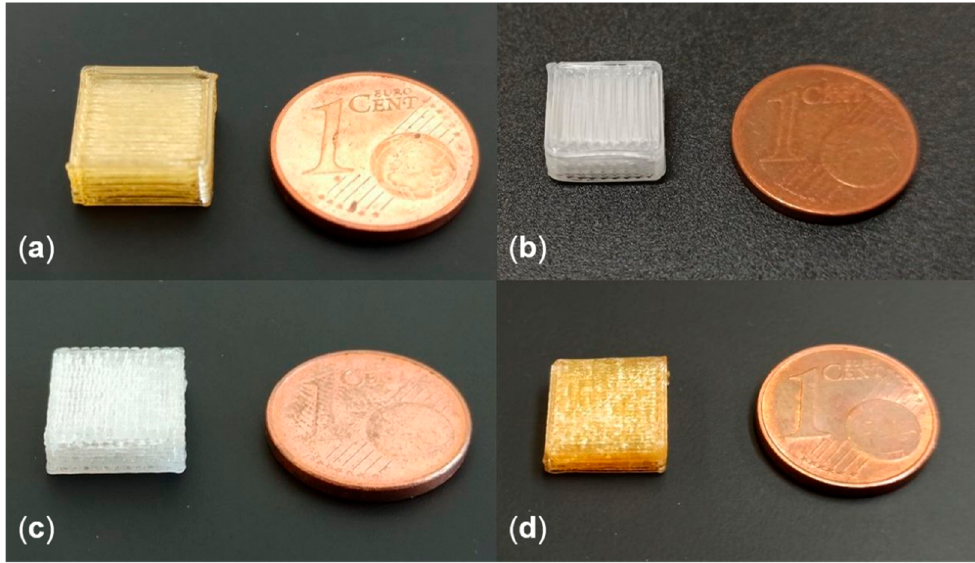
Figure 4. Successfully printed cuboids for EPO ( a ), EVA ( b ), PLGA ( c ) and PVPVA ( d ). The utilized printing parameters for the different materials are presented in Table 2.